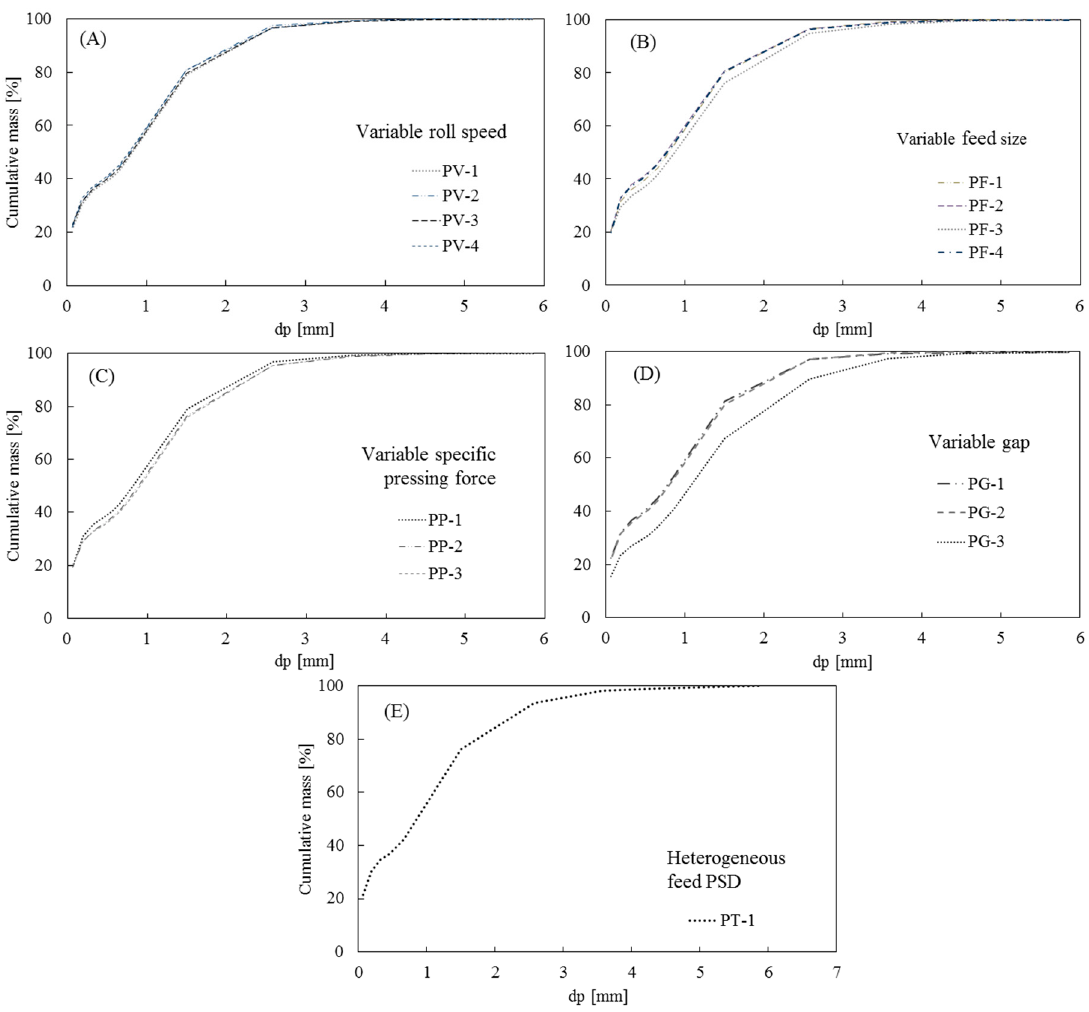
Figure 7. Product particle size distribution for experiments using the altered granite material. ( A ) Experiments PV-1 to PV-4, showing the effect of varying roll speed; ( B ) experiments PF-1 to PF-4, showing the effect of top feed size; ( C ) experiments PP-1 to PP-2, varying the specific pressing force; ( D ) experiments PG-1 to PG-3, varying the static gap and ( E ) experiment PT-1 using a heterogeneous feed particle size distribution.